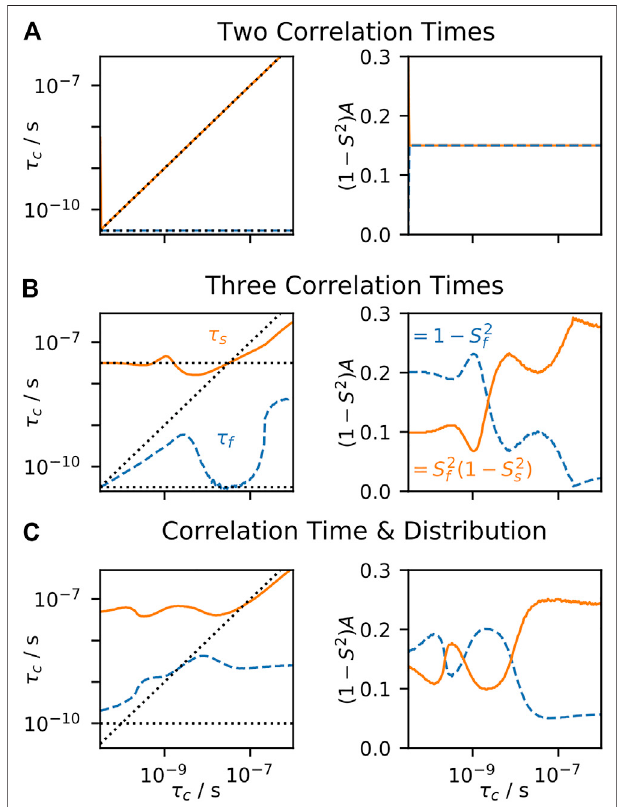
FIGURE5| EMFparametersasafunctionofinputcorrelationtime(solid- state). For each plot, a data set is calculated, including direct measurement of S resid. viaresidualcouplings( Eq.17 ), 15 N T 1 at400,500,and850 MHz,and T 2 with MAS of 60 kHz. The resulting rate constants are fi tted using the EMF approach. For all plots, (cid:10) 1 − S 2 (cid:11) (cid:2) 0.3. In each subplot, the fi tted correlation times (left) and amplitudes (right) are shown, as a function of an input correlation time ( x -axis). In (A) , the input correlation function has two correlation times (with equal amplitudes), with one fi xed at 3.2 ps, and the other swept. In (B) , the input correlation function has three correlation times, two fi xed at 3.2 ps and 32 ns, and the third is swept. In (C) , a log-Gaussian distribution of correlation times is used ( μ (cid:2) 100 ps, σ (cid:2) 0.75 orders of magnitude),andasinglecorrelationtimeisswept.Blackdottedlinesshowthe input correlation times (left